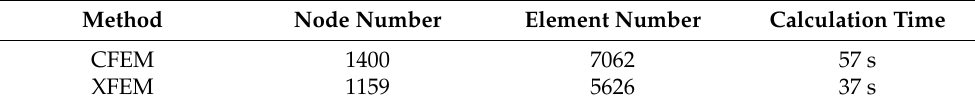
Table 1. Contrast of number of nodes and